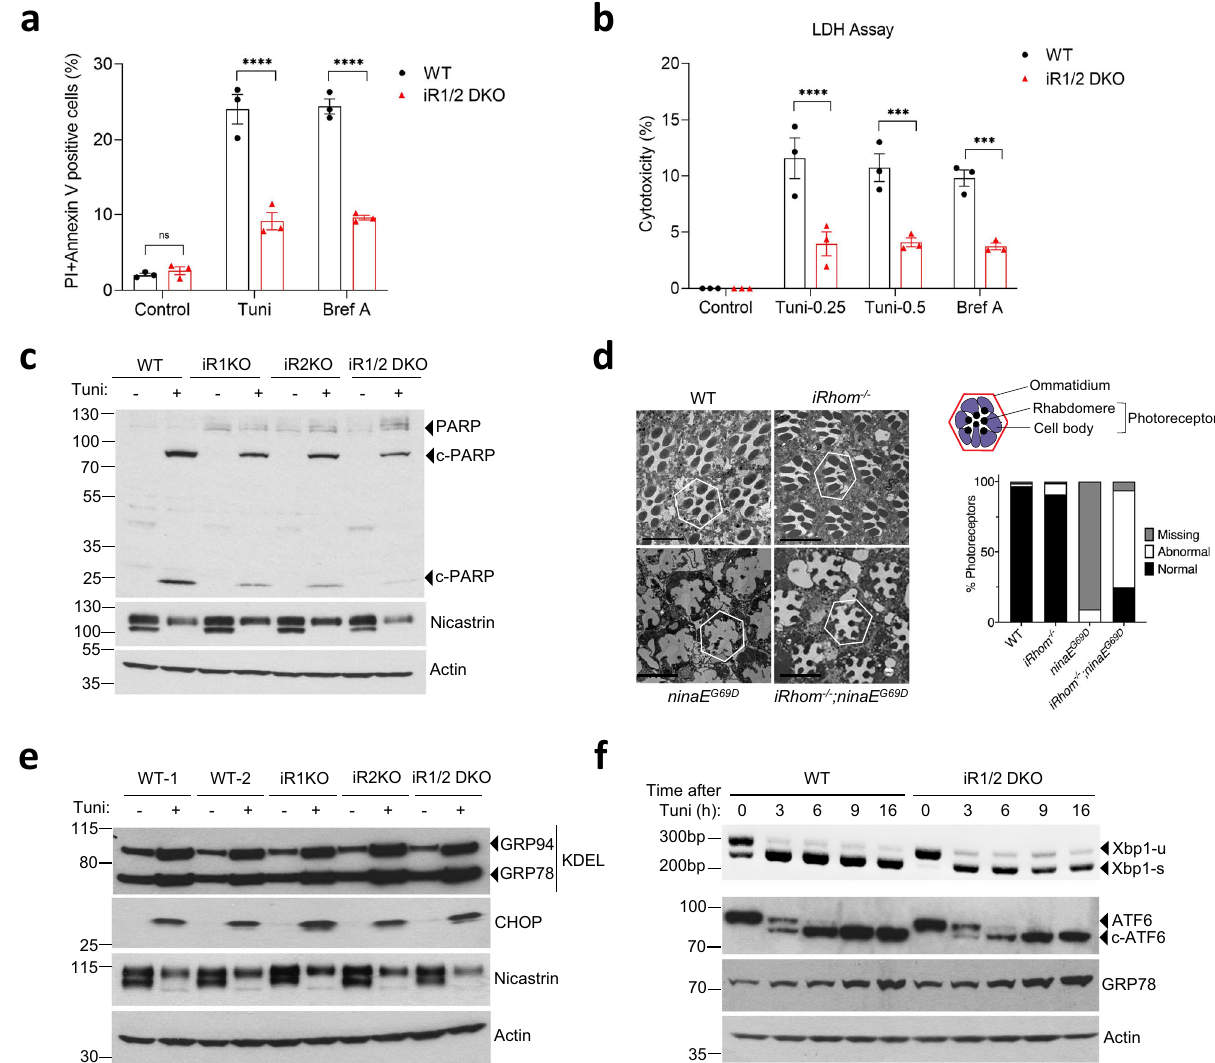
Fig. 1 iRhoms regulate ER stress-induced cell death. a Cell death of WT and iRhom1/2 DKO MEFs was measured after 18 h treatment with either tunicamycin (Tuni) (0.5 µ g/ml) or brefeldin A (Bref A) (1 µ g/ml) by PI/Annexin V staining using fl ow cytometry. Percentages of dead cells positive for both PI and Annexin V are shown in bar chart ( n = 3, biologically independent experiments). Data are expressed as mean ± SEM. Two-way ANOVA (Sidak ’ s), **** p < 0.0001 and ns = not signi fi cant. b Cell death of WT and iRhom1/2 DKO MEFs was determined after 18 h treatment with either tunicamycin (0.25 µ g/ml or 0.5 µ g/ml) or brefeldin A (1 µ g/ml) by lactate dehydrogenase (LDH) assay. Lactate dehydrogenase release in the extracellular medium was quanti fi ed and percentage cytotoxicity was determined and shown in bar chart ( n = 3, biologically independent experiments). Data are expressed as mean ± SEM. Two-way ANOVA (Sidak ’ s), *** p < 0.001 and **** p < 0.0001. c Cell lysates of WT, iRhom1 and iRhom2 knockout MEFs after exposure to tunicamycin (0.5 µ g/ml, 18 h) were analysed by immunoblotting with indicated antibodies. Black triangles denote full-length and cleaved proteins. d Representative transmission electron microscopy (TEM) images of 4-week old adult Drosophila retinas showing the overall structure of groups of ommatidia in a WT ( n = 34), iRhom − / − ( n = 204) , ninaE G69D ( n = 33) and iRhom − / − ; ninaE G69D ( n = 105) mutant fl ies, from two biologically independent experiments. Bar chart shows quanti fi cation of degeneration measured as the percentage of normal, abnormal and missing photoreceptors in each genotype indicated. Schematic of an ommatidium highlights its cellular structure. Scale bar = 10 µ M. e Cell lysates of WT, iRhom1 and iRhom2 knockout MEFs after exposure to tunicamycin (0.5 µ g/ml, 18 h) were analysed by immunoblotting with indicated antibodies. Anti-KDEL antibody detects both GRP94 and GRP78. f Splicing of Xbp1-u to Xbp1-s was determined using RT-PCR from mRNA (top panel) and cell lysates of WT and iRhom1/2 DKO MEFs exposed to tunicamycin (0.5 µ g/ml) for the indicated times were analysed by immunoblotting with indicated antibodies (lower panels). Immunoblotting and RT-PCR data are representative of 2 – 3 biologically independent experiments. Source data are provided as a Source data fi single iRhom gene 9 . Instead of chemical induction of ER stress, degeneration (Fig. 1d). This phenotype was signi fi cantly rescued we used a well characterised genetic model, induced by a in fl ies with a null iRhom mutation (the iRhom mutant fl ies have mutation in the ninaE gene ( ninaE G69D ), which encodes rhodopsin 1 28 . This mutant rhodopsin cannot fold properly, photoreceptors, and the few remaining have abnormal morphol- leading to ER stress in the photoreceptors, which in turn triggers ogy, whereas iRhom − / − ; ninaE G69D fl ies retain 93% of their cell death and retinal degeneration 29,30 . As expected, 4-week old photoreceptors and 25% of them have normal morphology ninaE G69D fl ies showed loss of photoreceptors and massive retinal (Fig. 1d). This genetic result in fl ies supports the mammalian cell